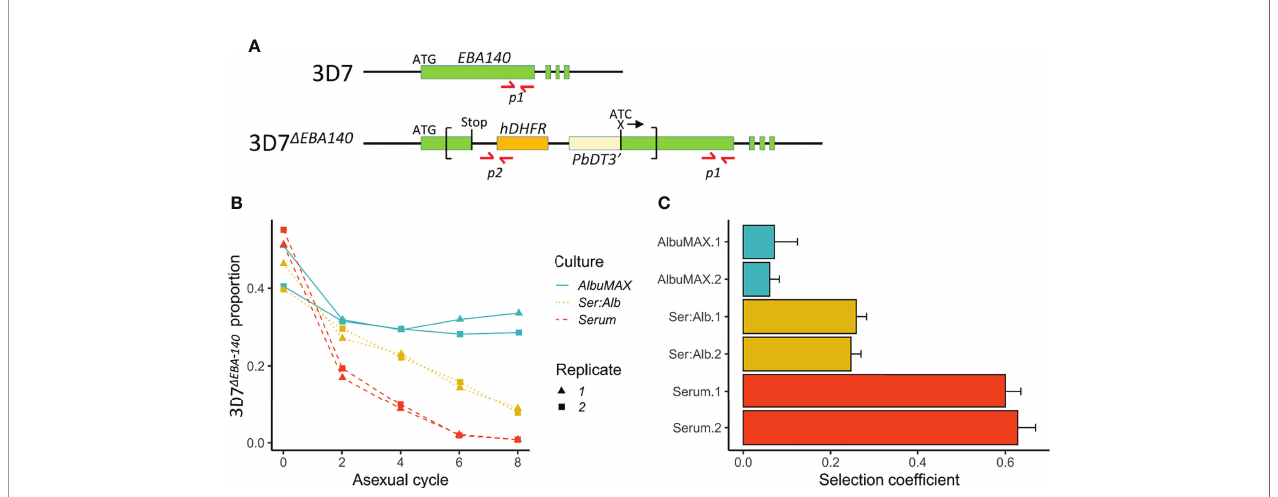
FIGURE 6 | Outcome of competition between 3D7 and 3D7 D EBA-140 under different culture conditions. (A) Design of qPCR primers. Top, structure of the 3D7 EBA- 140 gene locus; bottom, disrupted EBA-140 gene locus in 3D7 D EBA-140 . The recombinant plasmid pHH1 D EBA-140 (sequence shown inside the square brackets, was integrated into the EBA-140 gene during the generation of 3D7 D EBA-140 (Maier et al., 2003). The locations of the qPCR primers are labeled with red arrows. Amplicon p1 (arrows indicate forward and reverse primers) is located at the 3 ’ end of the EBA-140 gene and ampli fi es DNA from both 3D7 and 3D7 D EBA-140 . Amplicon p2 was designed to cover the junction between the human dihydrofolate reductase gene ( hDHFR ) (orange box) and a short upstream sequence within the pHH1 D EBA140 plasmid and can only be ampli fi ed from 3D7 D EBA-140 . (B) The proportion of 3D7 D EBA-140 over eight parasite asexual cycles. (C) Selection coef fi cients ( s ) of 3D7 D EBA-140 with 1× standard error. Positive values of s indicate a disadvantage to 3D7 D EBA-140 . Culture conditions: Ser:Alb culture media contains both serum and AlbuMAX in a 50:50